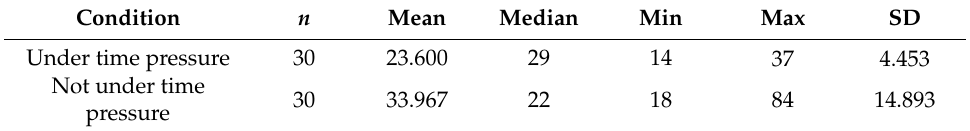
Table 4. Descriptive statistics for the number of products viewed.